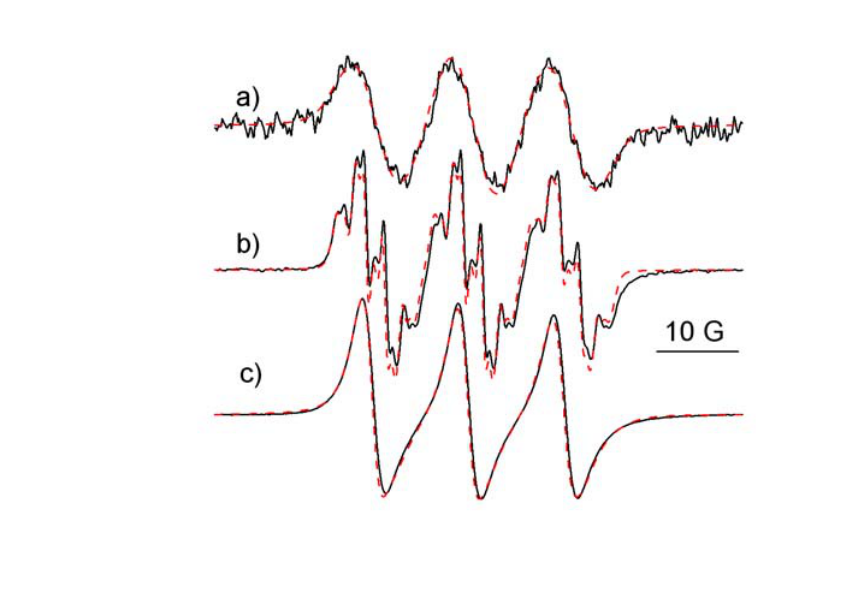
Fig. 1 Experimental EPR spectra (black lines) of a) 1 / • CH 2 OH, b) 2 / • CH(CH 3 )OH and c) 6 / • CH 2 OH, obtained in pH 7.2 phosphate buffer by carrying out a Fenton